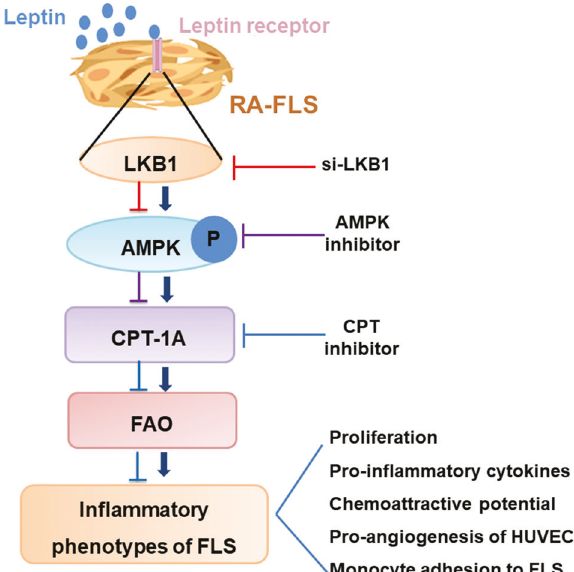
Fig. 8 A proposed model of how leptin activates FAO in RA-FLS through LKB1-AMPK pathway. FLS play an important role in the pathogenesis of RA. Our results show that leptin-LKB1/AMPK pathway promots the maintenance of pro-in fl ammatory character- istics in FLS through upregulating cellular fatty acid β -oxidation (FAO). Blocking FAO and/or depleting leptin will contribute to the alleviation of synovial in fl ammation elicited by